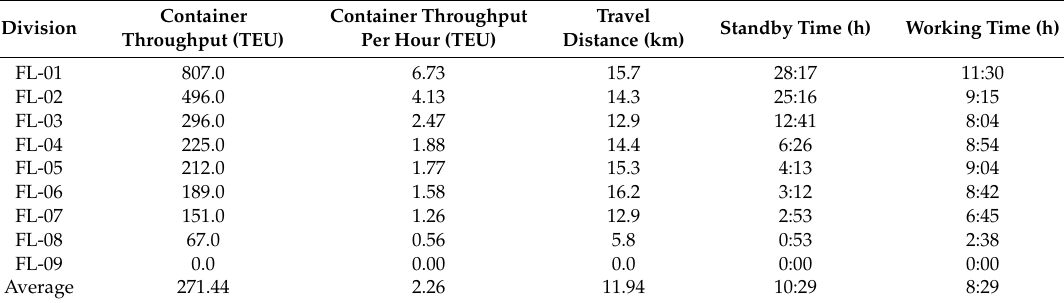
Table 4. Simulation results of virtualized port-container terminal